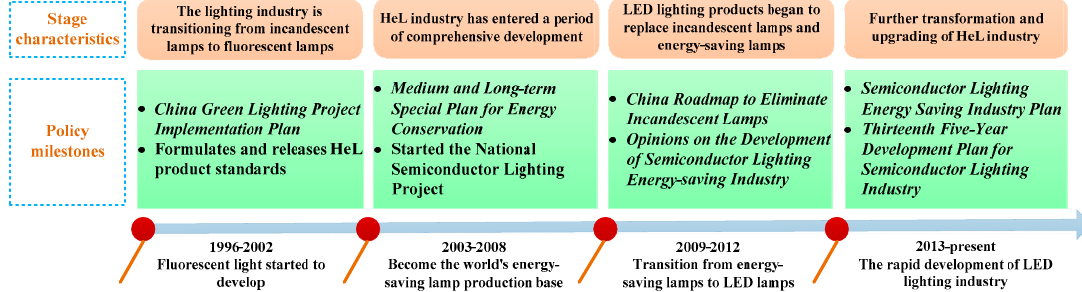
Figure 1. The development stage and important policy milestones of green lighting industry.